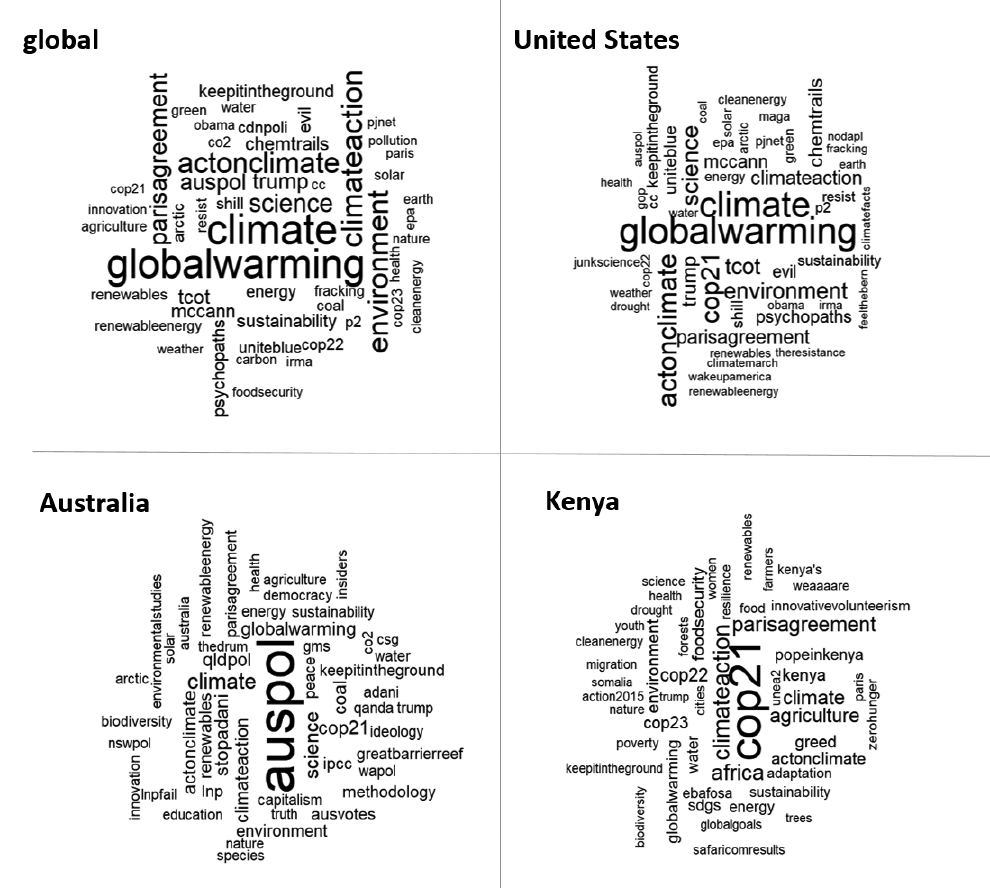
Figure 5. Wordclouds of top 50 co-occurring hashtags for #Climate Change in the global Twittersphere and selected na- tional user communities. Notes: N (global) = 291,053; N (US) = 178,060; N (Australia) = 46,148; N (Kenya) = 8,602.